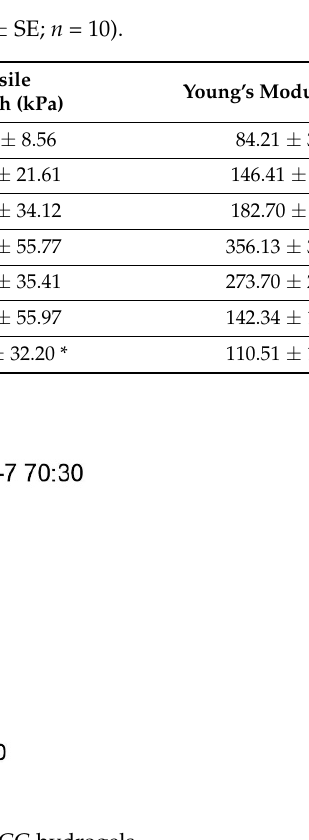
Figure 6. Typical tensile stress–strain curves of PVA/MCC hydrogels. A tendency can be observed as the increase in cellulose correlates to an increase in both tensile strength and Young’s modulus in the 7 cycle-treated hydrogels; while in the 14 cycle-treated ones, it correlates to a decrease in these values. Such behavior might be attributable to a reinforcement effect that the cellulose has towards the PVA hydrogels [39–41] and to the increase in the number of freeze–thaw cycles [42–44]. In fact, it is re- ported that PVA-based hydrogels, irrespective of the preparation methods, become more resistant when cellulose is added, even in low amounts. Our results show a gradual in- crease in tensile strength from 249.10 ± 8.56 to 638.21 ± 34.12 kPa as the cellulose content in PVA/MCC-7 hydrogel increased from 10% to 30%. With the increment of the cellulose incorporated, the elastic modulus also increased by a factor of 2.17, from 84.21 ± 3.23 to 182.70 ± 9.18 kPa. Ren and collaborators attributed this behavior to the high strength of the compact structure of the cellulose network and to the beneficial interaction at the in- terface between the cellulose and PVA network [40]. This results in the loss of intramolec- ular interactions of PVA in favor of intermolecular cellulose-PVA interactions. The for- mation of these new interactions then strengthens the hydrogels. It is also true, however, that the strength of PVA-based hydrogels does not increase indefinitely as the number of freeze–thaw cycles increases—after six, it reaches a plateau when assessed with both ten- sile and compressive tests [44,45]. In fact, each cycle causes a remodeling in the PVA struc- ture due to ice formation that produces regions with higher concentration of polymer. It could then be hypothesized that the high number of freeze–thaw cycles change the micro- structural rearrangement of the PVA due to hydrogel phase separation that cause an in- creased density of regions rich in water and polymer. Furthermore, this process is be- lieved to push the PVA chains closer to each other, facilitating the formation of crystallites and permanent physical cross-linkages inside the hydrogel network. In this hypothesis, cellulose produces fewer interactions with PVA despite its increased content. Therefore, the strength of the hydrogel remains, de facto, anchored only to the cross-linking of the PVA which, decreasing in concentration, produces less strong hydrogels. The chitosan scaffold showed values of 110.51 ± 19.33 kPa for elastic modulus and 163.89 ± 32.2 kPa for tensile strength, the lowest of the values measured. Data on the tensile strength of the corneal stroma are reported in the literature, but these often have a high variability. Zhang et al. [46] obtained 1530 ± 860 and 550 ± 220 kPa of tensile strength values and Young’s modulus values of 1160 ± 1420 kPa and 1410 ± 1350 kPa for anterior and posterior stroma, respectively. Other authors observed much lower elastic modulus values for anterior and posterior stroma, ranging from 245.9 ± 209.1 to 281 ± 214 kPa and from 100.2 ± 61.9 to 89.5 ± 46.1 kPa, respectively [47,48].